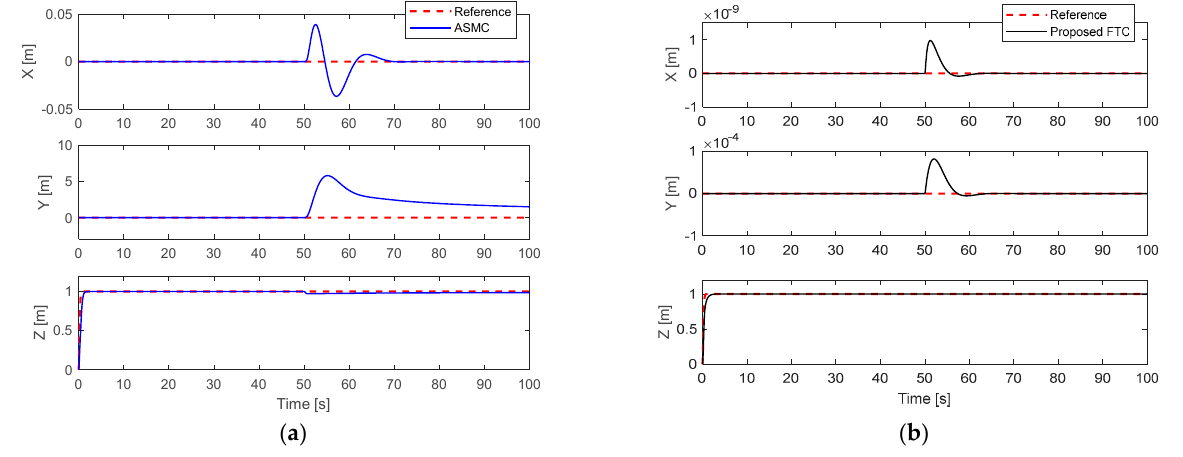
Figure 2. Altitude and position performance with 50% LoCE in actuator #2: ( a ) ASMC; ( b ) Proposed FTC.